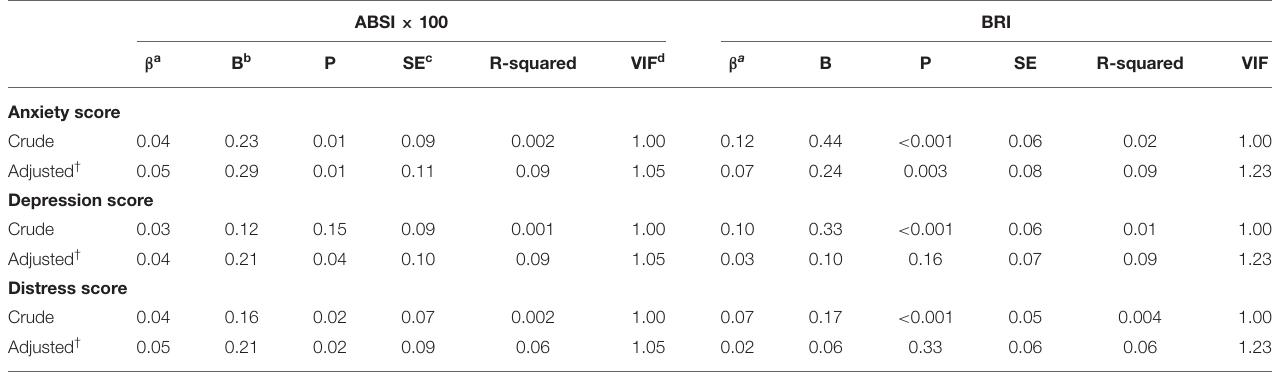
TABLE 6 | Linear association of ABSI and BRI with anxiety, depression and distress scores. ABSI ×